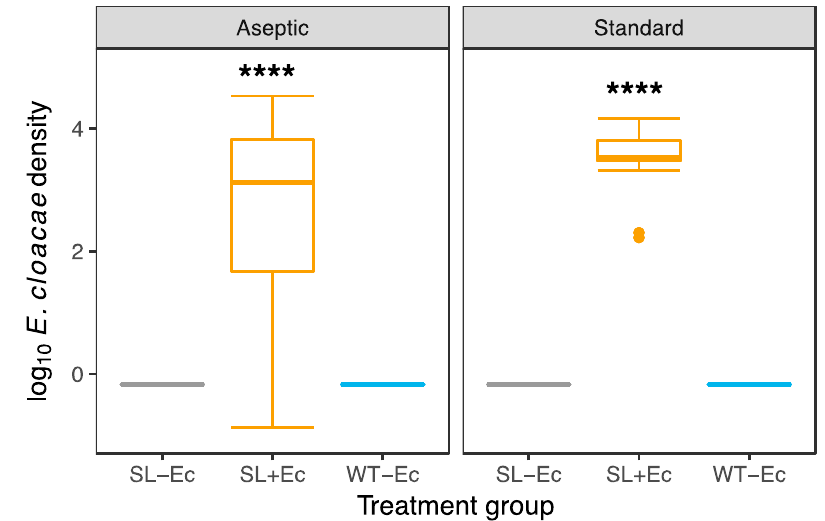
Figure 1. Culturable bacterial densities in inoculated (SL + Ec) and symbiont-free treatment groups ( − Ec) under aseptic and standard conditions. Bacterial densities were assessed in self-limiting (SL) transgenic larva that had Enterobacter cloacae added to their diet (SL + Ec) and compared to SL larva without E. cloacae in their diet (SL − Ec) and wild type (WT) larva without E. cloacae in their diet (WT − Ec). In aseptic conditions, in the SL + Ec treatment, 94 out of 96 larvae were successfully inoculated with JJBC. In standard conditions, all SL + Ec ( n = 8) contained the focal symbiont. In both standard and aseptic conditions, treatments that were not inoculated with Ec had bacterial densities of 0 c.f.u. / µ L (WT − Ec (aseptic: n = 36, standard n = 7) and SL − Ec (aseptic n = 60, standard n = 8). Bacteria in the inoculated larvae were streptomycin resistant and confirmed in morphology to our focal E. cloacae JJBC 11.1B strain. Asterisks indicate that inoculated treatments SL + Ec contain significantly more microbes than uninoculated treatments ( p < 0.0001 in Kruskal-Wallis tests).